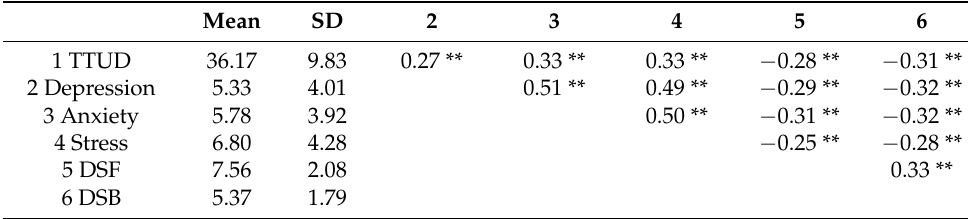
Table 3. Pearson’s correlations between research variables.